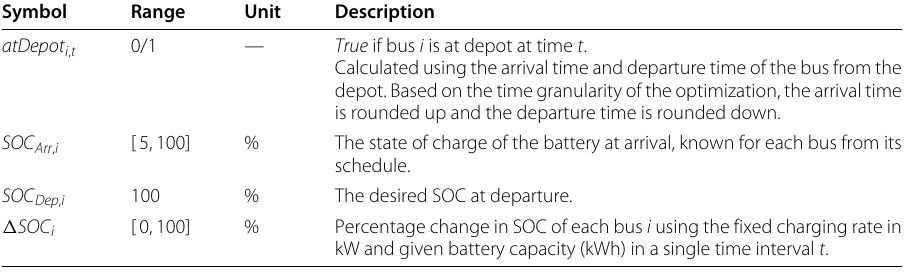
Table 2 Parameters